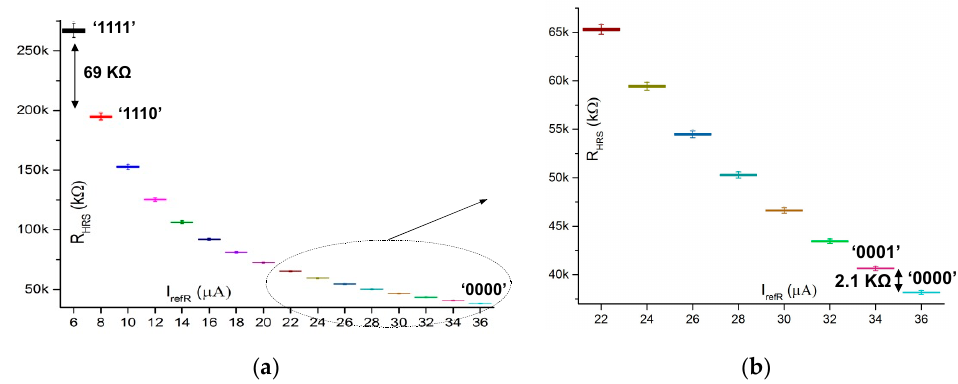
Figure 11. ( a ) HRS resistance box plots obtained after 500 MC simulations for 16 RST compliance currents ranging from 6 μ A to 36 μ A. ( b ) Expanded view of the HRS box plots for currents ranging from 22 μ A to 36 μ A.